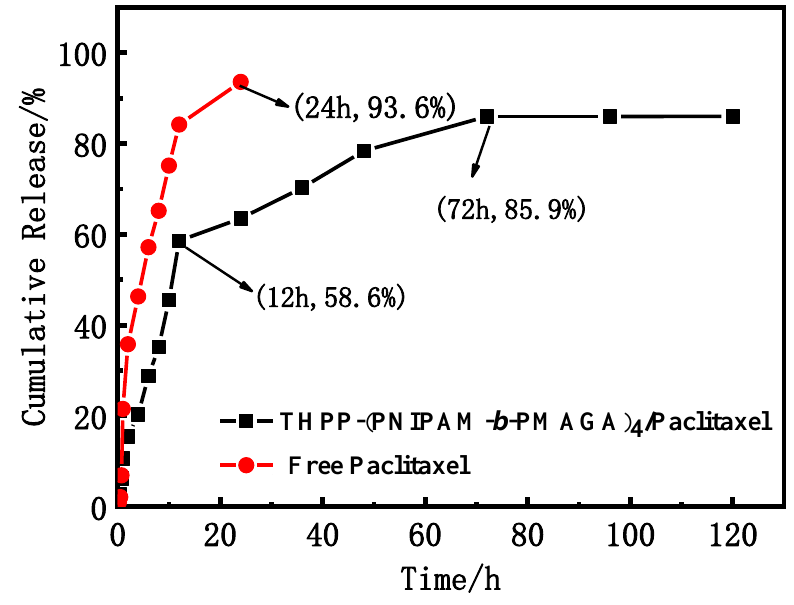
Figure 8. Cumulative release curve of the free paclitaxel and the THPP-(PNIPAM- b - PMAGA) 4 /paclitaxel in PBS.